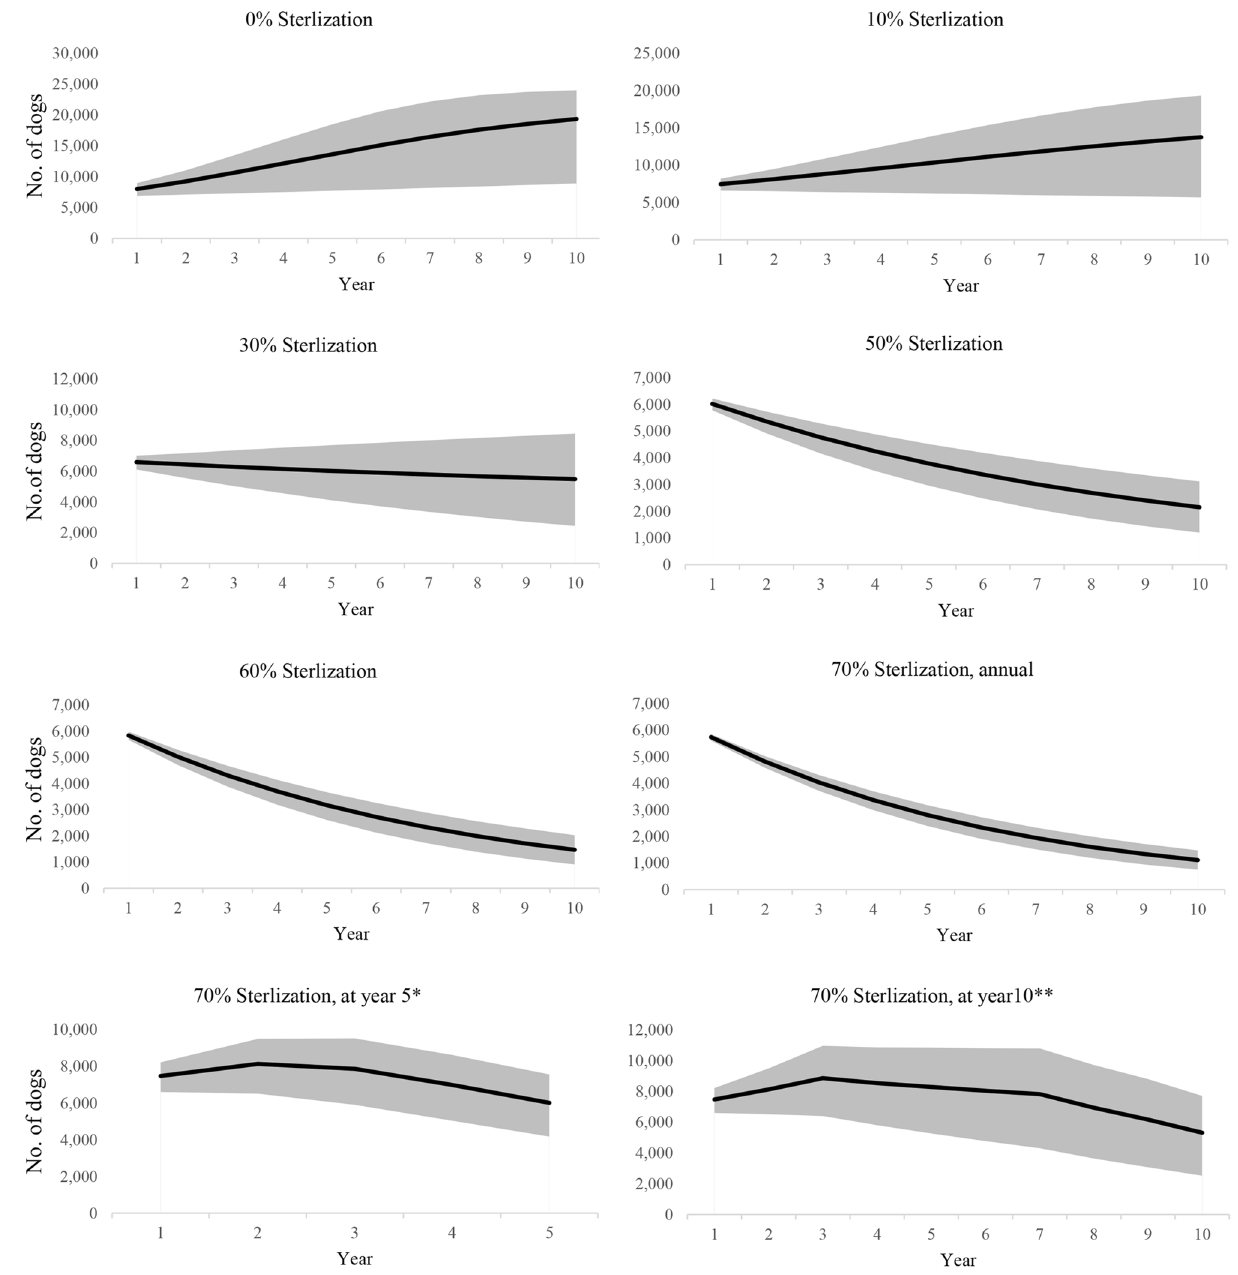
Figure 3. Dog population model predictions according to five different scenarios of animal birth control in a 5- and 10-year intervention program (*Consistent spaying of dogs over 5 years so as to cover 70% of the females in the final year. **Consistent spaying of dogs over 10 years so as to cover 70% of the females in the final